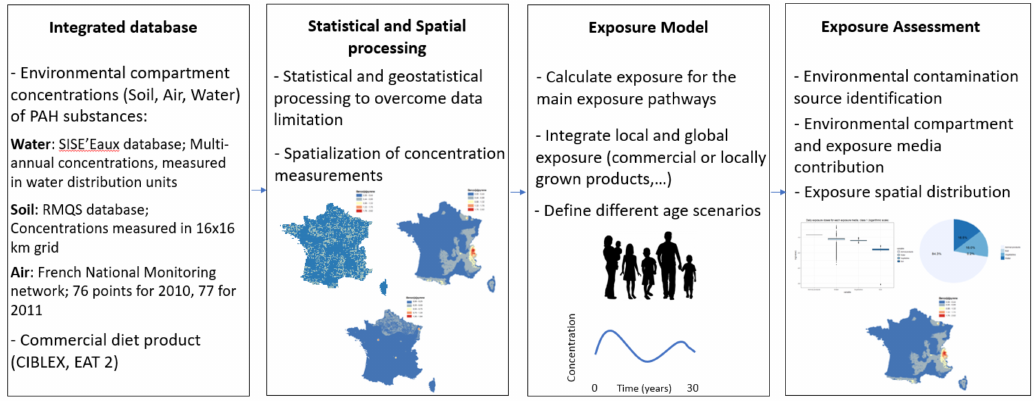
Figure 1. Illustration of the exposure assessment